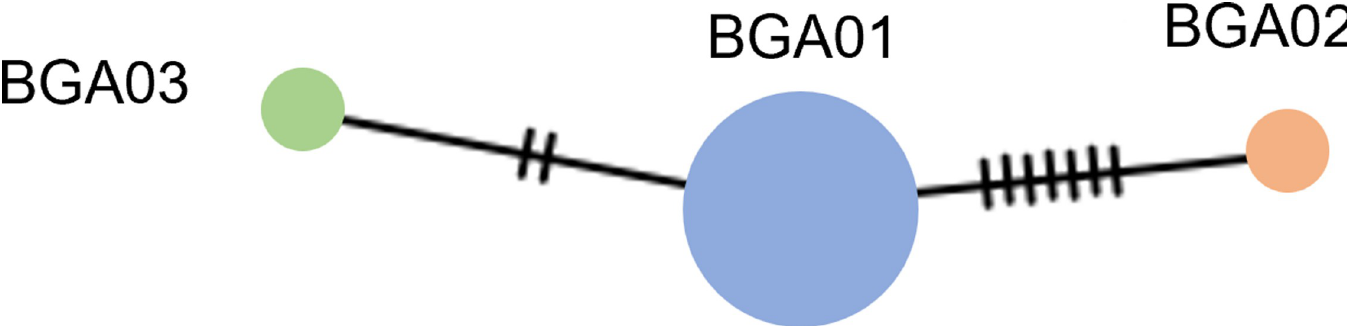
Fig 2. Haplotype network derived from nucleotide data for mitochondrial D-loop sequencing of wild bull ( Bos gaurus , Smith, 1827) for 13 individuals. Different colors distinguish the samples. Each circle represents a unique DNA sequence (haplotype), with the circle diameter reflecting the total number of individuals possessing the haplotype.